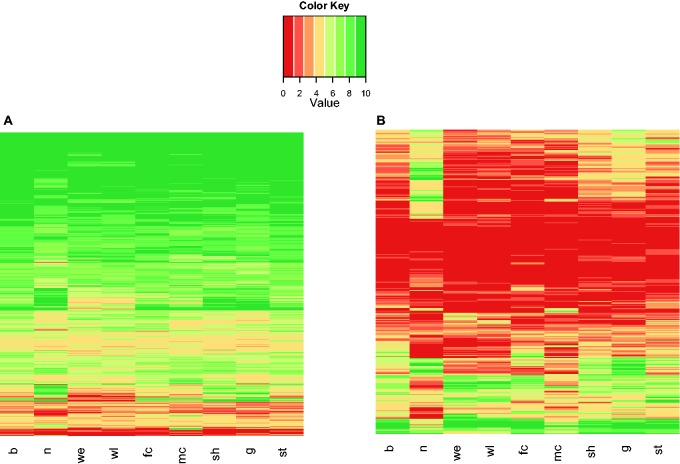
Heatmaps showing gene expression profiles in P. abies. (A) Expression profiles of orthologous single-copy genes in P. abies; (B) Heatmap showing diversified expression profiles among paralogous genes of the LRR gene family. Each row is a gene and each column is a tissue. Expression levels vary from 0 (lowly expressed) to 10 (highly expressed). Tissues studied included buds (b), needles (n), wood-early (we), wood-late (wl), female cone (fm), male cone (mc), shoots (s), galls (g), and stems (st).